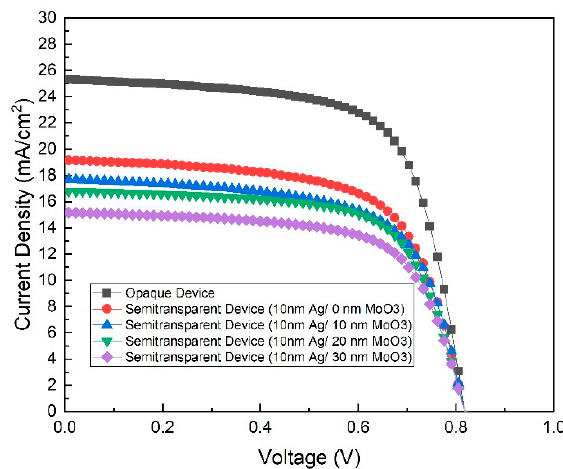
Figure 2. The current density to voltage ( J-V ) curves of the opaque device and all fabricated semi-transparent devices.